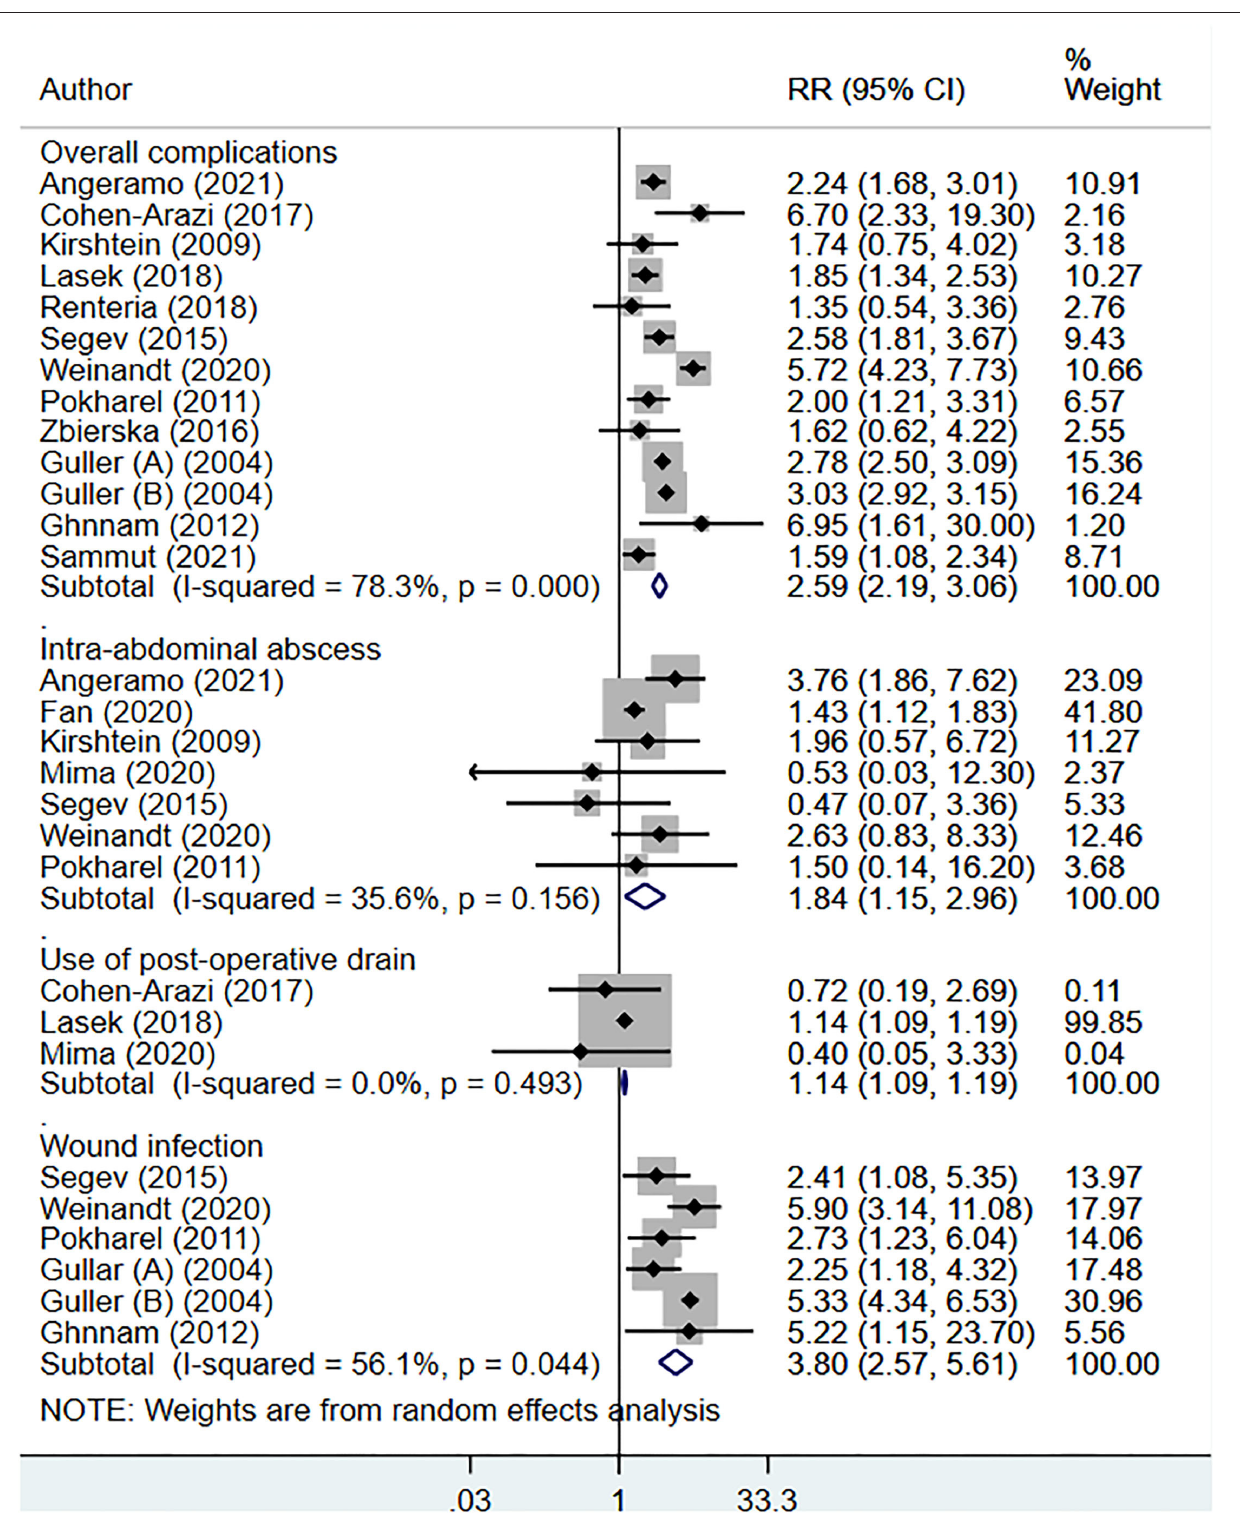
FIGURE 4 | Postoperative complications of appendectomy among elderly subjects, compared to non-elderly subjects.